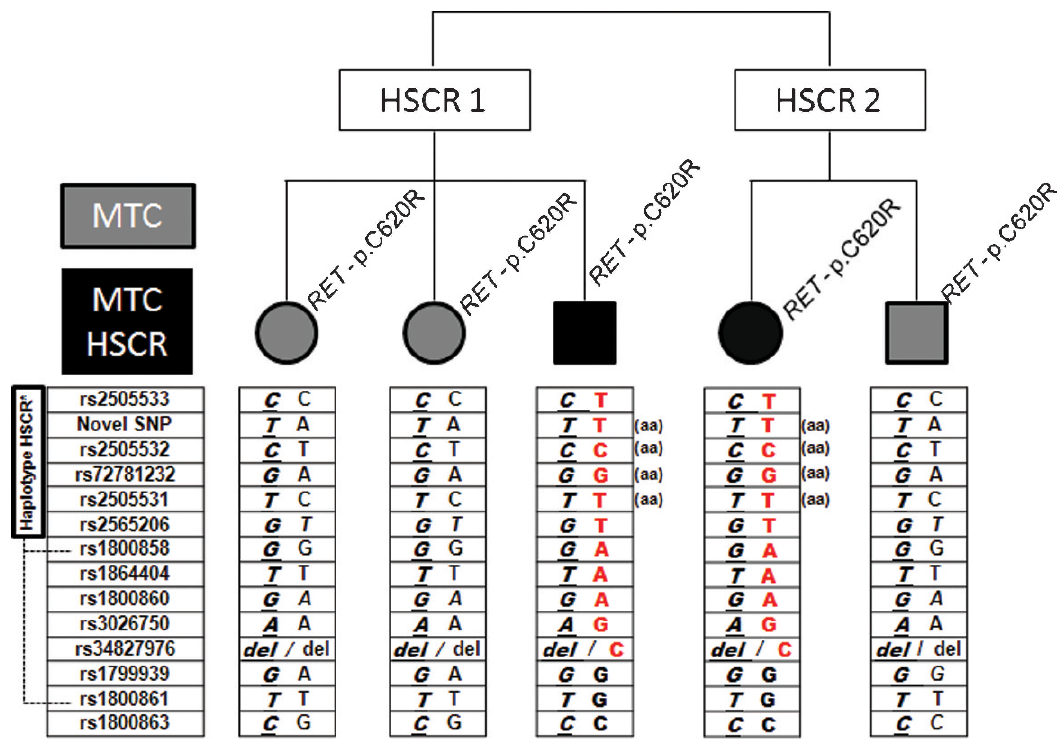
Figure 1 - Identification of different haplotypes, including the rs2505533 and rs34827976 SNPs, in relatives with MTC/HSCR or MTC alone (non-HSCR) who carry the C620R RET mutation. The observed haplotype in the HSCR/MTC patients (red) contains the region previously recognized as related to the sporadic and familial forms of HSCR (1,2). Four SNPs within this region are only homozygous (aa) in patients with HSCR.